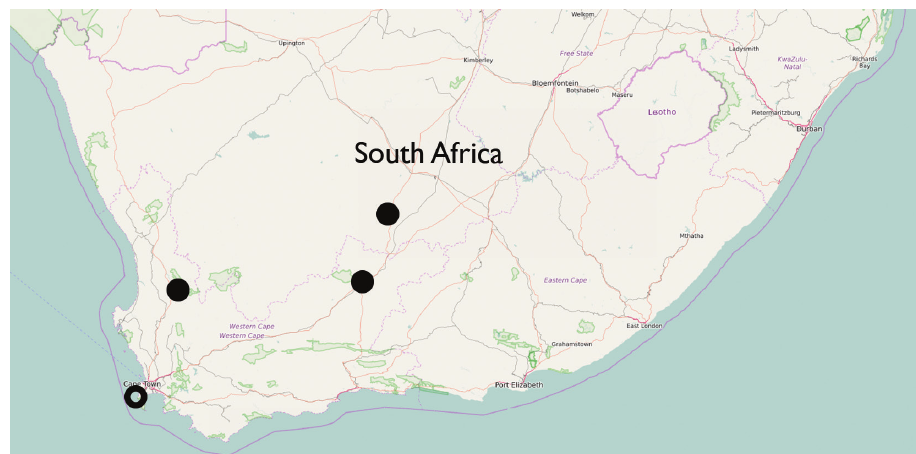
Figure 27. Distribution of Diaphorocellus biplagiatus . The type locality (open circle) and new records listed in the text (solid